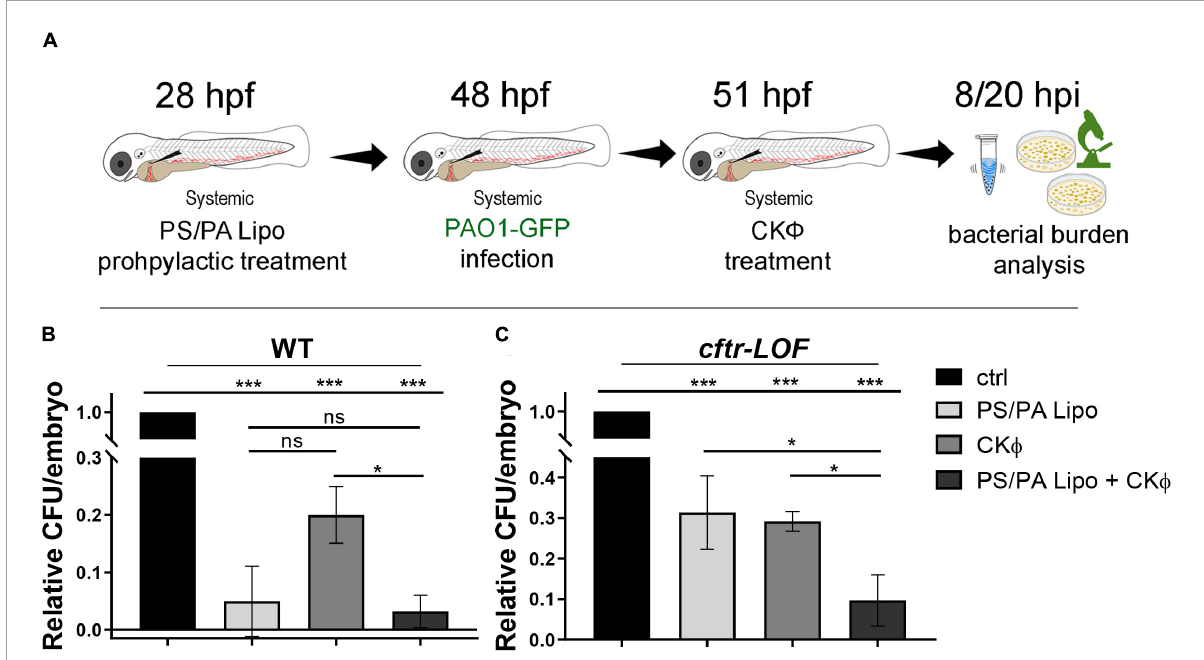
FIGURE3 Antimicrobial activity in WT and cftr -LOF zebrafish embryos of the combination treatment with phosphatidylserine/phosphatidic acid (PS/PA) liposome in prophylactic administration and phage therapy. (A) Schematic representation of PS/PA liposome prophylactic treatment followed by systemic bacterial infection and CK (cid:56) -administration. Zebrafish embryos were treated with PS/PA liposome at 28 hpf, then systemically infected with PAO1-GFP at 48 hpf, treated with CK (cid:56) 3 h later, and analyzed for bacterial burden at 8 or 20 h post infection. (B,C) Bacterial load (relative CFU/embryo) in systemically infected wild-type (WT) (B) , and cftr -LOF embryos (C) , control (ctrl), PS/PA liposome, CK (cid:56) and PS/PA liposome + CK (cid:56) treated. Statistical significance was assessed by One-way ANOVA followed by Tukey’s post hoc test: *** p < 0.001; * p < 0.05; ns, not significant. Data resulted from three independent experiments and results are presented as mean ±